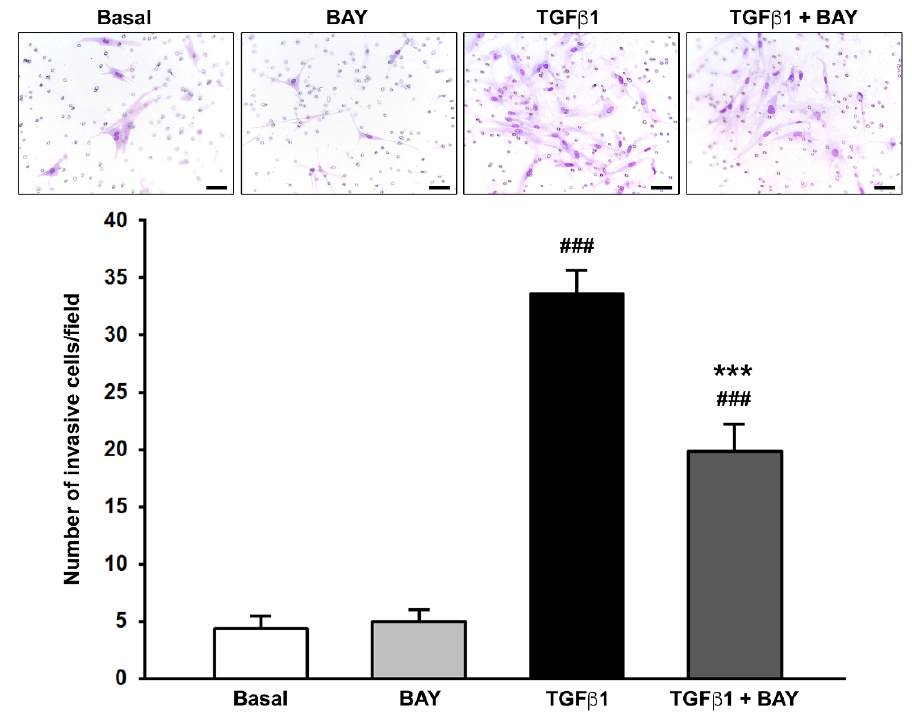
Figure 4. Soluble guanylate cyclase stimulation with BAY 41-2272 significantly reduces TGF β 1-induced invasiveness of human keratocytes in the Matrigel chemoinvasion assay. Representative images of the filters with invasive cells stained with Diff-Quik are shown (original magnification: ×40). Scale bar: 50 μ m. Histograms represent the results of quantitative analysis of chemoinvasion expressed as the number of migrated cells per field. Data are mean ± SEM of triplicate determinations from five cell lines. ### p < 0.001 vs. basal condition, *** p < 0.001 vs. TGF β 1 alone (Tukey’s test). SEM, standard error of the mean; TGF β 1, transforming growth factor β 1.